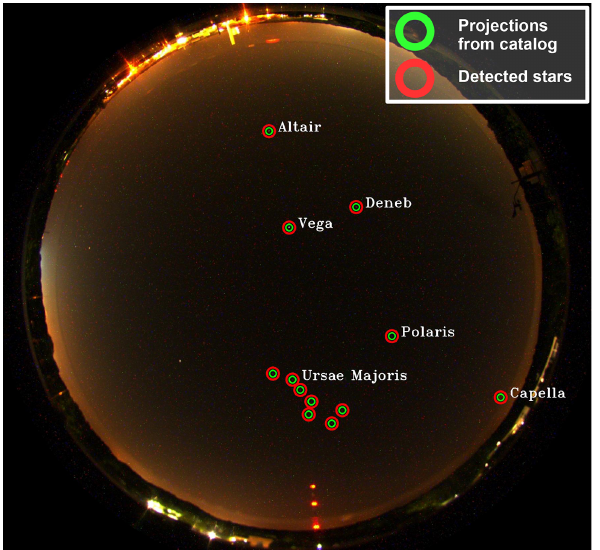
Figure 7. Absolute orientation estimation via stars from long- exposure images. In case of an accurate orientation estimation, the projected coordinates from the star catalog should match the de- tected stars in the image.